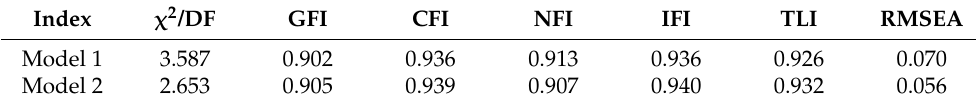
Table 4. Fit indices of Models 1 and